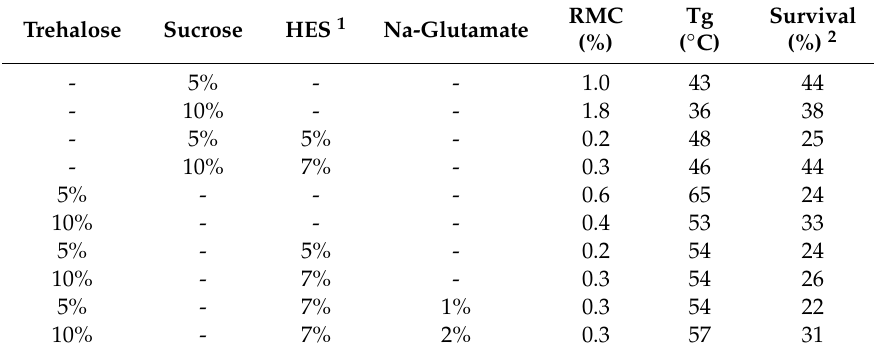
Table 3. Residual moisture content, glass transition temperature and bacterial survival as a function of lyophilization bu ff er